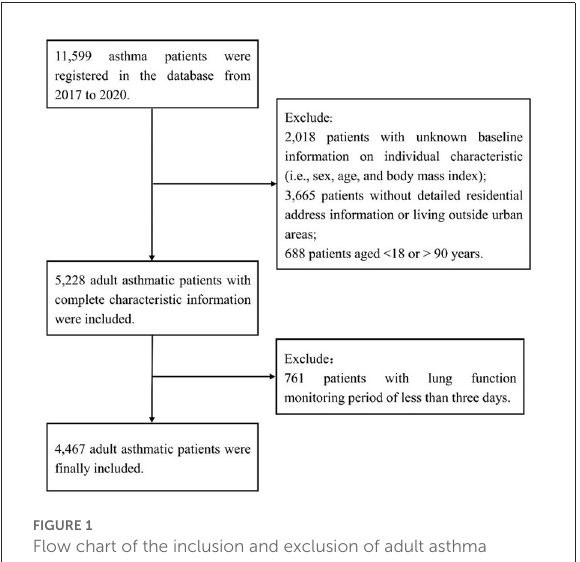
FIGURE1 Flow chart of the inclusion and exclusion of adult asthma patients.